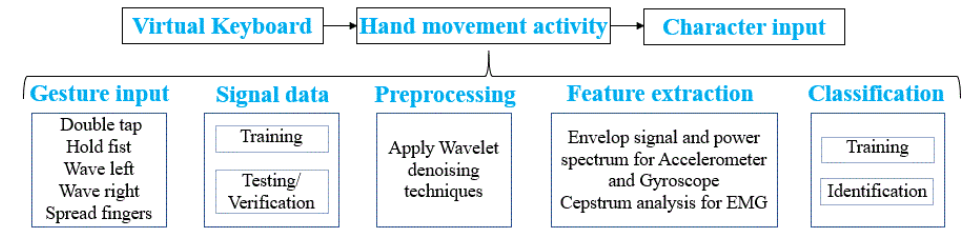
Figure 1. Basic structure of a character input system based on gesture